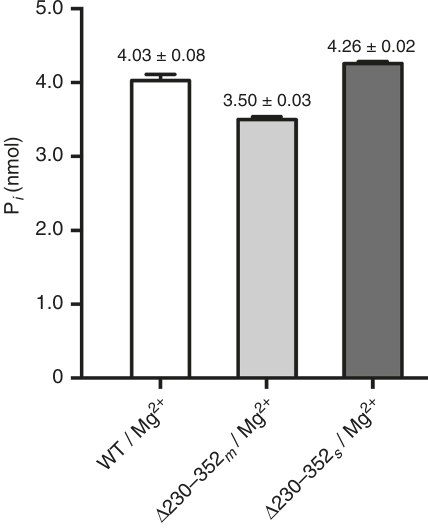
Fig. 5 Activity of Pf DPMS wild type and truncation variant Δ 230 – 352. Amount of product formed measured as nanomoles of released free phosphate for wild-type Pf DPMS and the truncation variant Δ 230 – 352 lacking the TM domain. Dol55- P was used as acceptor substrate. Δ 230 – 352 Δ 230 – 352 fi ed from the membrane fraction m and s were puri and aqueous phase, respectively; and they display catalytic activity comparable with that of the wild type. Errors are given as mean values ± s. e.m. ( N =